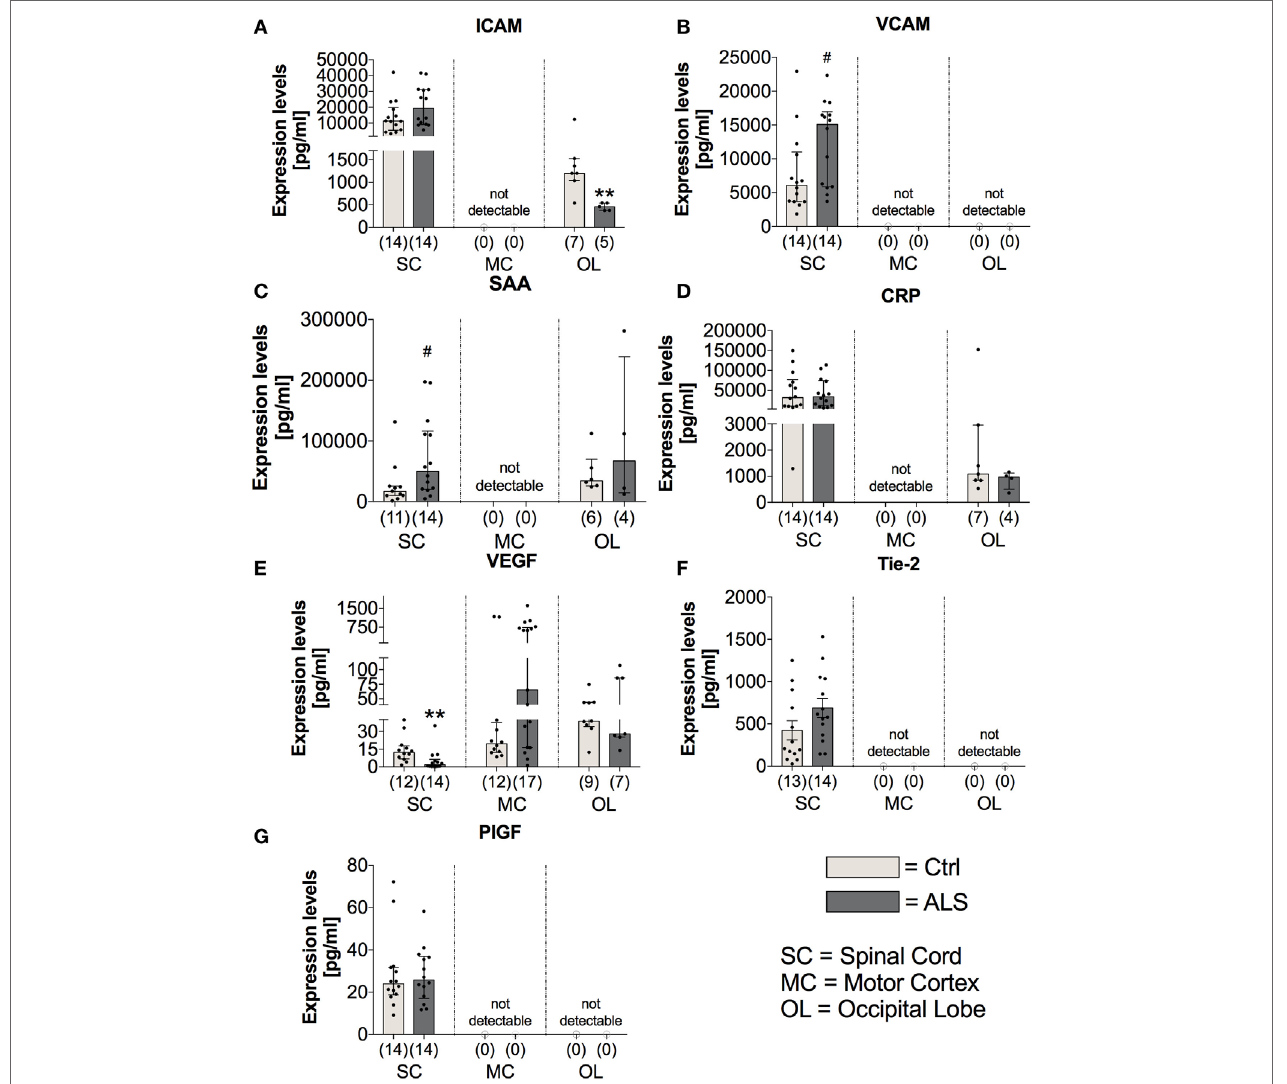
FigUre 8 | Tissue concentrations of vascular, general inflammation, and angiogenic markers. Amyotrophic lateral sclerosis (ALS) patients exhibited an unchanged expression profile of the vascular and fibrosis­mediating factor ICAM (a) within the spinal cord (SC), no detectable amounts in the motor cortex (MC) and a significant reduction in the occipital lobe (OL) (a) . For VCAM (b) , there was a strong trend toward upregulated amounts in the SC of ALS patients and no detectable levels in the MC and OL (b) . The general inflammatory marker SAA (c) tended to be upregulated in the SC of ALS patients (SAA, C) or were unchanged or not detectable in the other central nervous system (CNS) regions. The second common marker for inflammation, CRP, was unchanged in all all of the three CNS regions (D) . Further, for angiogenic factors including VEGF (e) , Tie­2 (F) , and PIGF (g) only VEGF was significantly reduced in the SC of ALS patients, whereas the other two factors were not altered in the SC and not detectable in any of the two remaining CNS regions. ** p < 0.001 vs. controls (Ctrl); # = trend, p = 0.057 for VCAM, # = trend, p = 0.058 for SAA. Numbers of patients are given in brackets; all parameters were tested for Gaussian distribution using D’Augostino­Pearson omnibus normality test. Two­tailed Mann–Whitney test for ICAM, VCAM, SAA, CRP (OL), VEGF, PIGF, data represent median with interquartile range; two­tailed unpaired Student’s t ­test for CRP (SC) and Tie­2, data represent mean ±